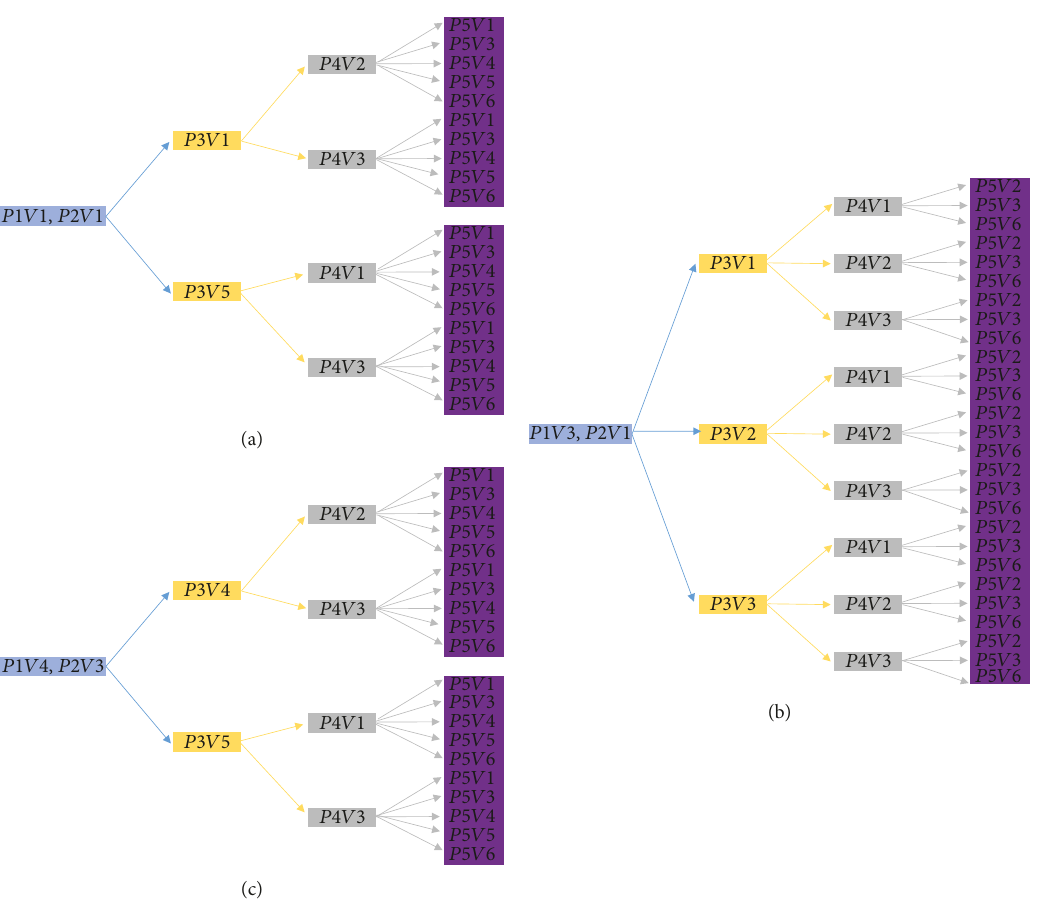
Figure 8: Example of unique optimal combinations for the cells associated with policies 1, 2, and 3 (a, b, and c,